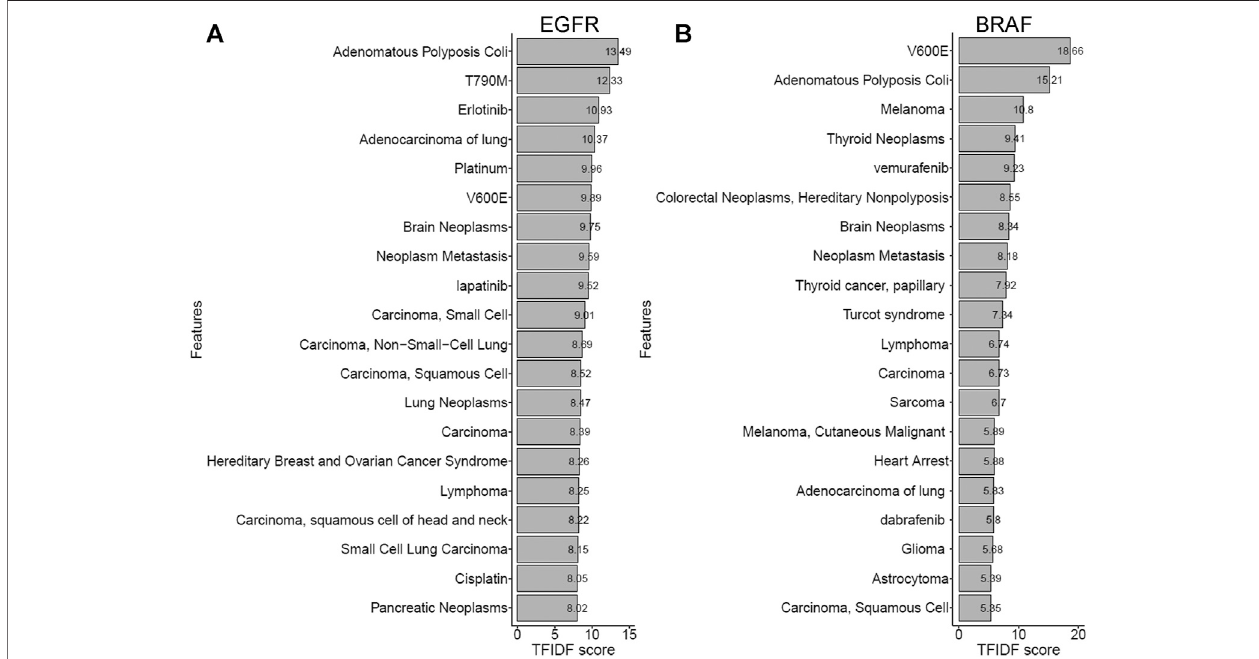
FIGURE 4 | Top term features in EGFR and BRAF genes (A) The bar chart shows the TF-IDF scores of term features related to EGFR . Most of the identi fi ed term featuresfor EGFR wereassociatedwithsyndromes(e.g.,lungadenocarcinomaandnon-smallcelllungcarcinoma),mutations(e.g.,T790M),andtherapies(e.g.,erlotinib and lapatinib) for lung cancer. (B) The bar chart shows the TF-IDF scores of term features related to BRAF . Biomedical term features, including cancer types (e.g., melanoma and thyroid cancer), mutations (e.g., V600E), and inhibitors (e.g., vemurafenib and dabrafenib) for BRAF , were consistent with known fi